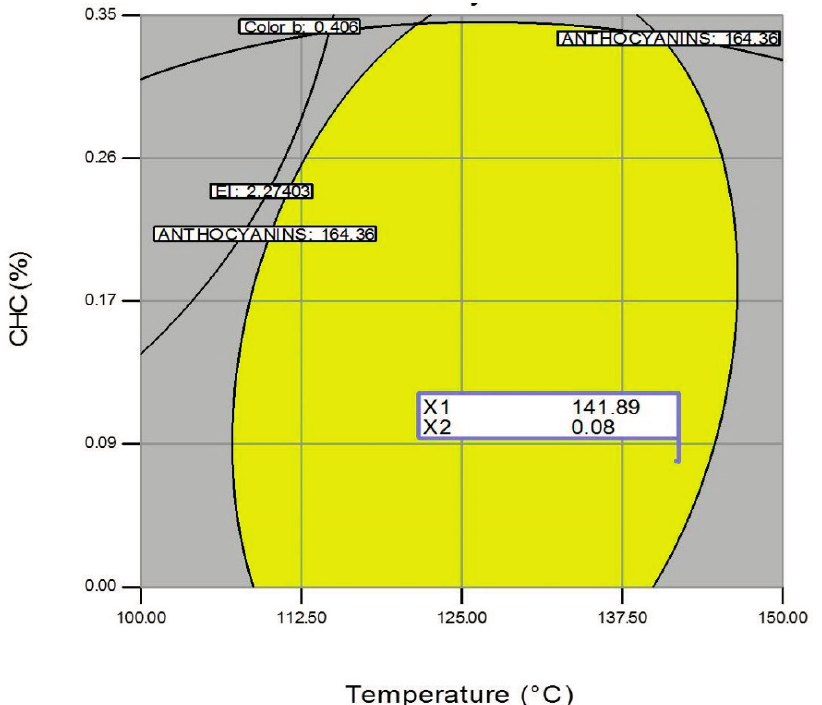
Figure 9 . Overlay plot and optimized region (best combination) of the extrusion processing factors temperature (T) and calcium hydroxide concentration (CHC), for producing expanded nixtamalized blue corn